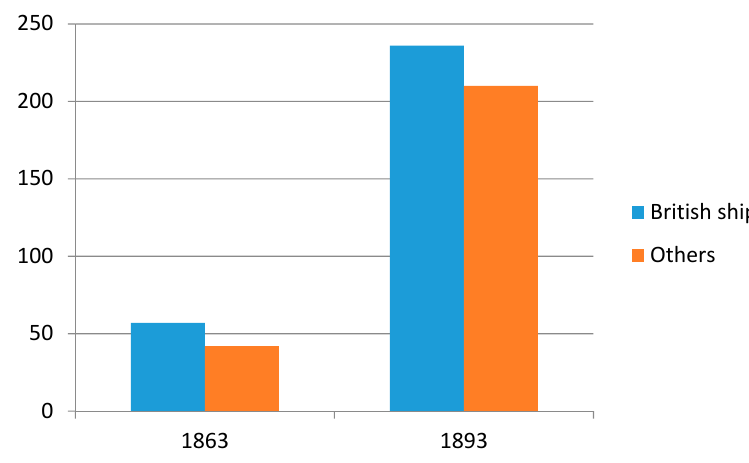
Figure 1. Number of ships that called at the Nigerian coast [22].